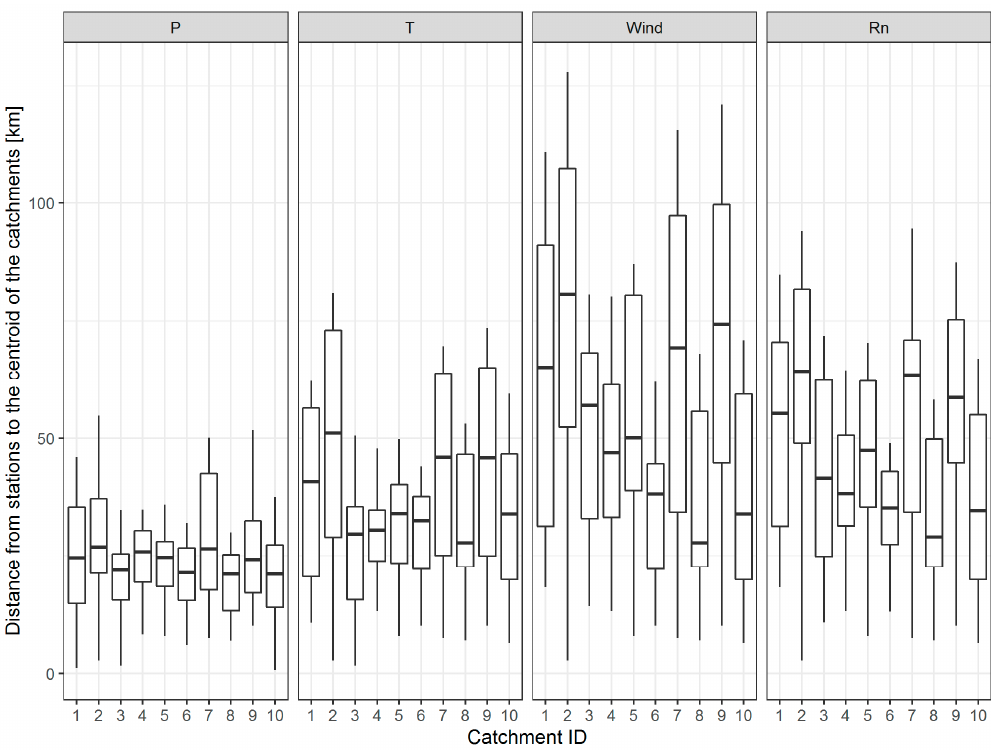
Figure 2. The distances (calculated as boxplots) of the meteorological sensors: precipitation from gauges (P), global radiation (Rn), temperature (T), and wind speed (Wind) from the centroids of the catchments in the OSW. Note the difference in scales used for the vertical axis.